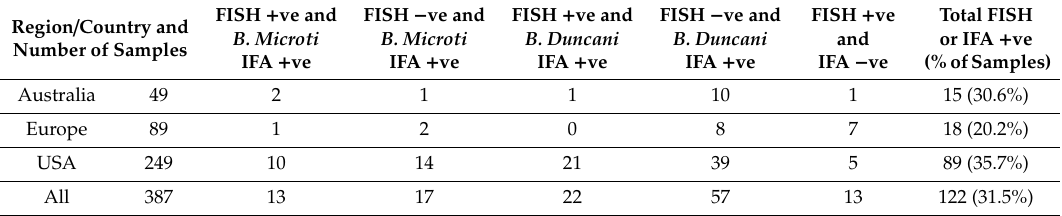
Table 3. Comparison of diagnostic findings for babesiosis in Australia, Europe and the USA. FISH + ve and FISH − ve and FISH + ve and Region / Country and B. Microti B. Microti B. Number of Samples IFA + ve IFA + ve